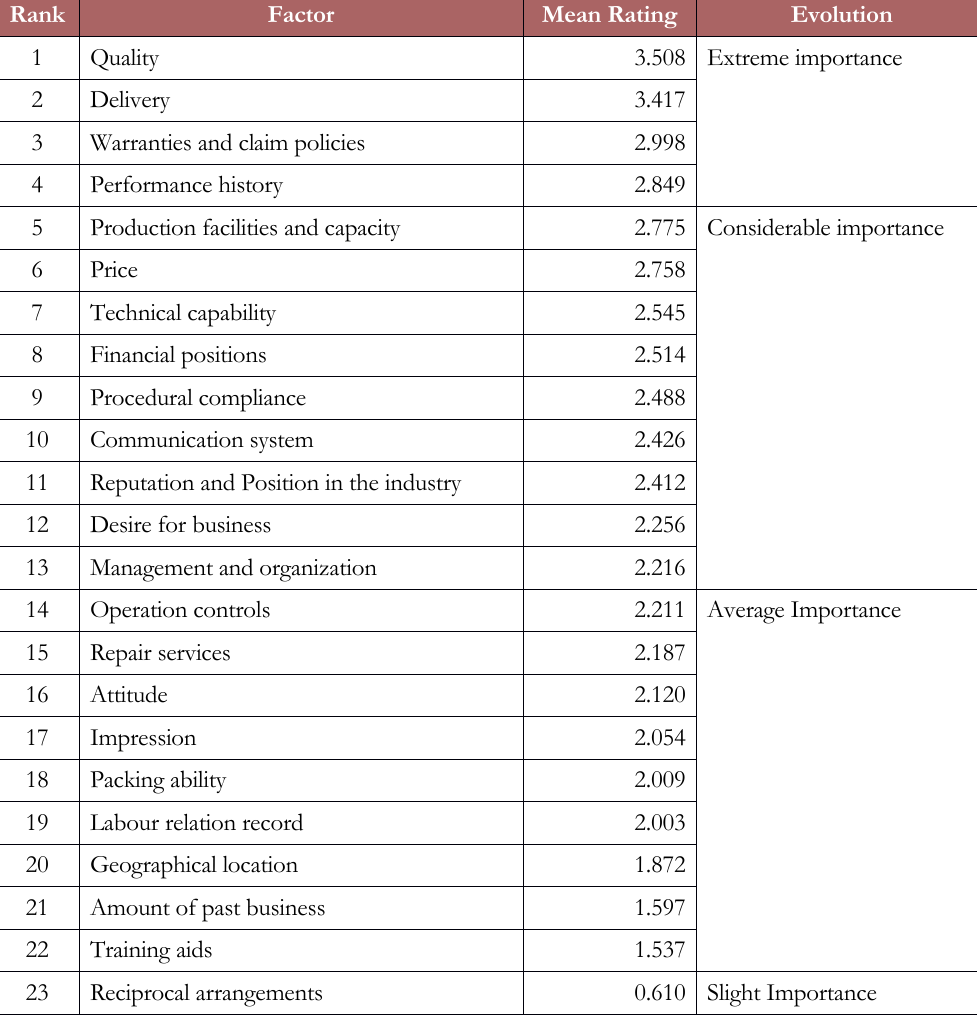
Table 1. Dickson factors (Imeri,